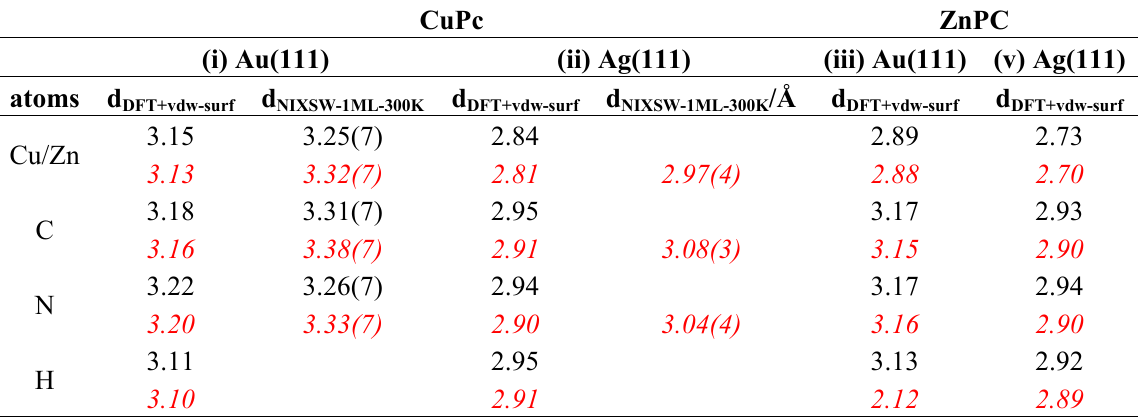
Table 1. Computed adsorption heights d (reported in Å) of the metal Pc molecules on Au(111) and Ag(111) surface. The experimental results taken from Ref. [51,53] and obtained by normal incidence X-ray standing wave (NIXSW) experiments at 300K and full coverage are listed for comparison. The distances measured at ~140 K differ from those at 300 K by ≤ 0.04 Å for the Au (111) substrate and by ≤ 0.05 Å for the Ag(111) substrate. The values printed in black represent the distances to the average positions of the topmost metal layer (where in the experiments an outward relaxation of the top Au layer of 3% has been assumed [53] based on X-ray data measured for clean Au(111) [55]). § This is the key distance that determines the magnitude of the vdW interaction. Values in red ( italic ) refer to distances relative to a hypothetical unrelaxed top Au layer, as this is the quantity actually determined by NIXSW. The situation on Au(111) is, in fact complicated by the long-range surface reconstructions (whose explicit treatment is far beyond present computational capacities). They result in a “buckling” of the top metal layer, which already in [43] has been argued to result in an increased deviation between calculated and measured